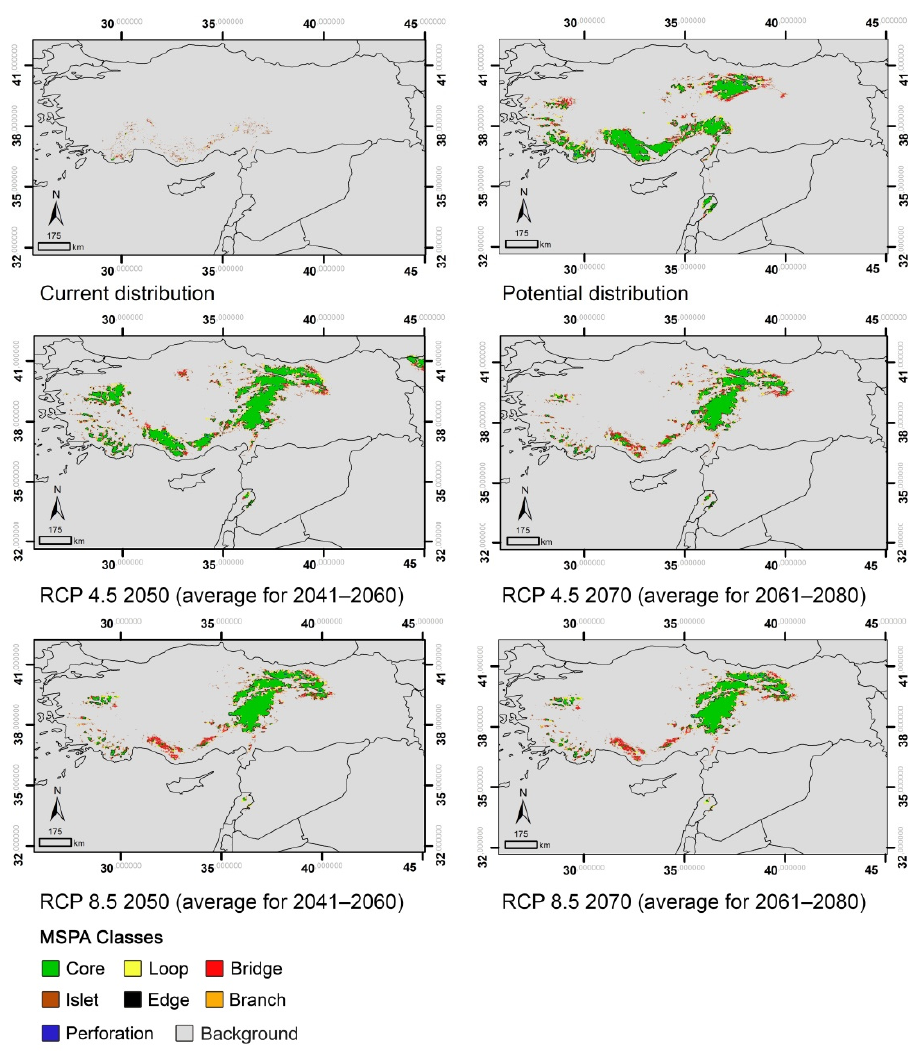
Figure 3. MSPA classes of current, potential, and future habitats of the Lebanon cedar.